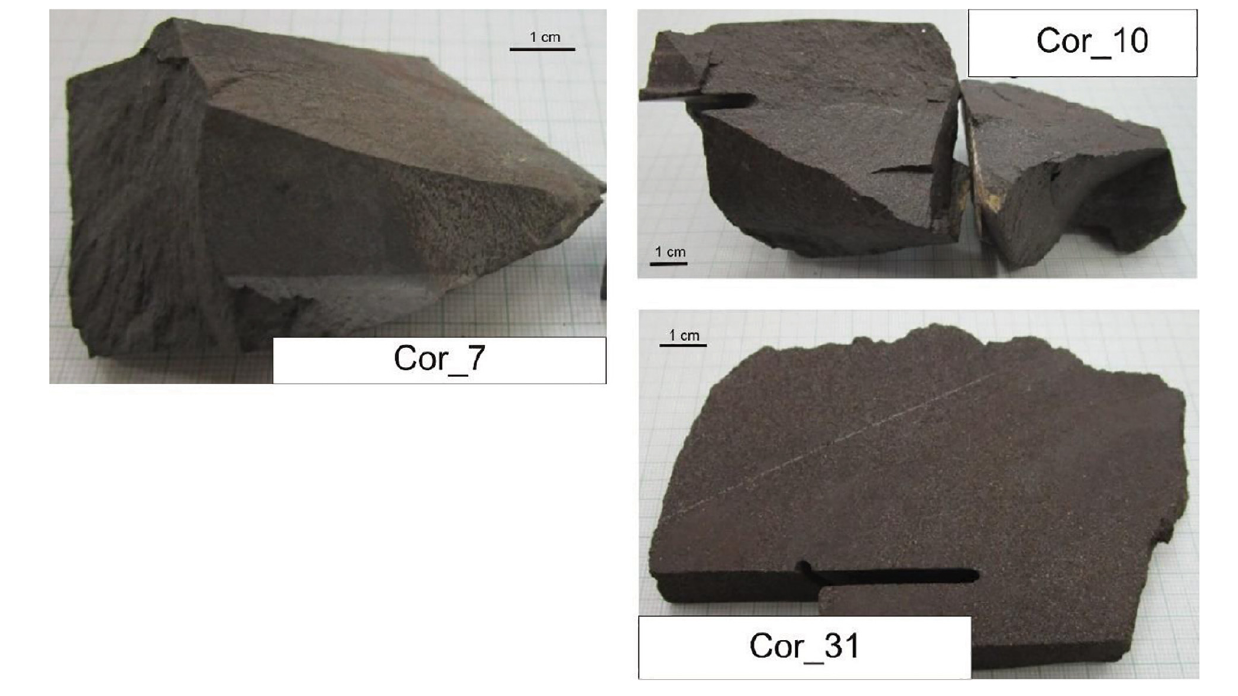
geological samples, but its usage in the case of X-ray amorphous material, like most microbially mediated samples, is not